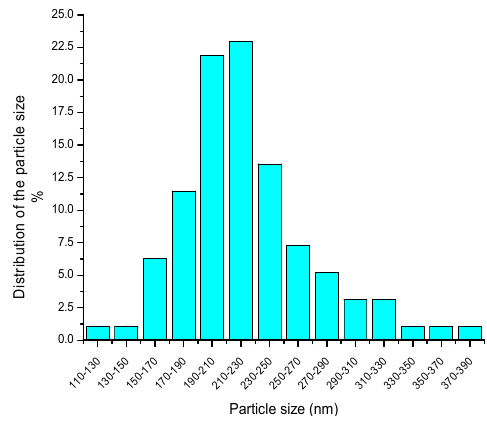
Figure 9. The distribution of the particle size on the cross-section.